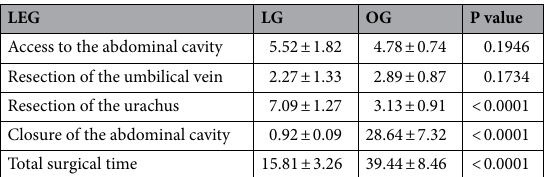
Table 1. Results of surgical time for each step of laparoscopy and celiotomy performed for resection of umbilical vein and urachus in bovine fetuses.